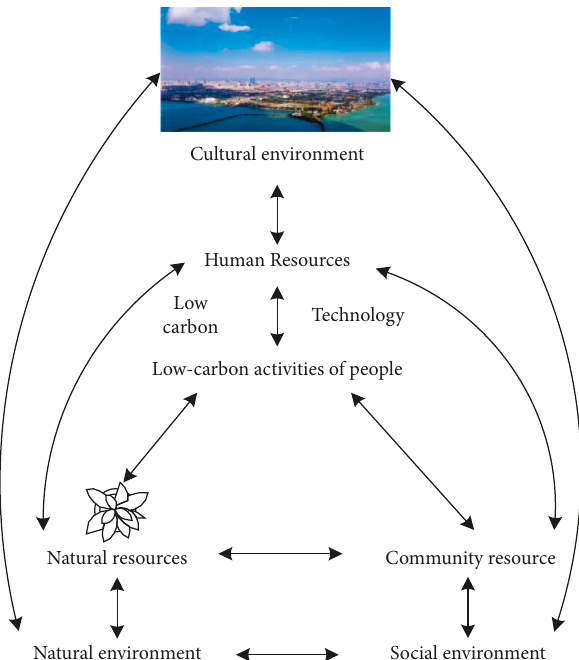
Figure 1: Schematic diagram of low-carbon economic activities and their mechanism of